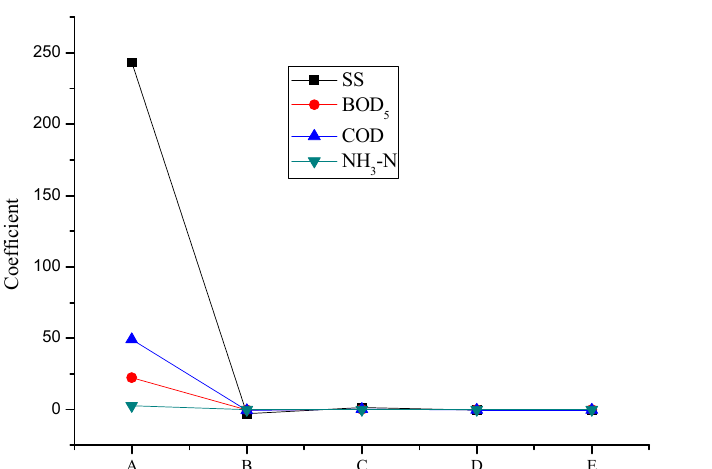
Figure 6. The influence coefficient of land-use on water quality indexes. Note: A — Constant; B — Green space ratio; C — EIA ratio; D — Proportion of artificial permeable surface; E — ineffective impervious area (IIA) ratio.